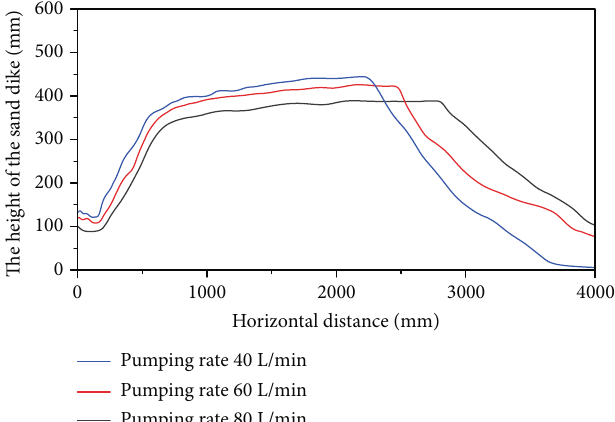
Figure 6: The shape of the sand dike formed by proppant sedimentation in sand carrying by slickwater with di ff erent pumping rates.